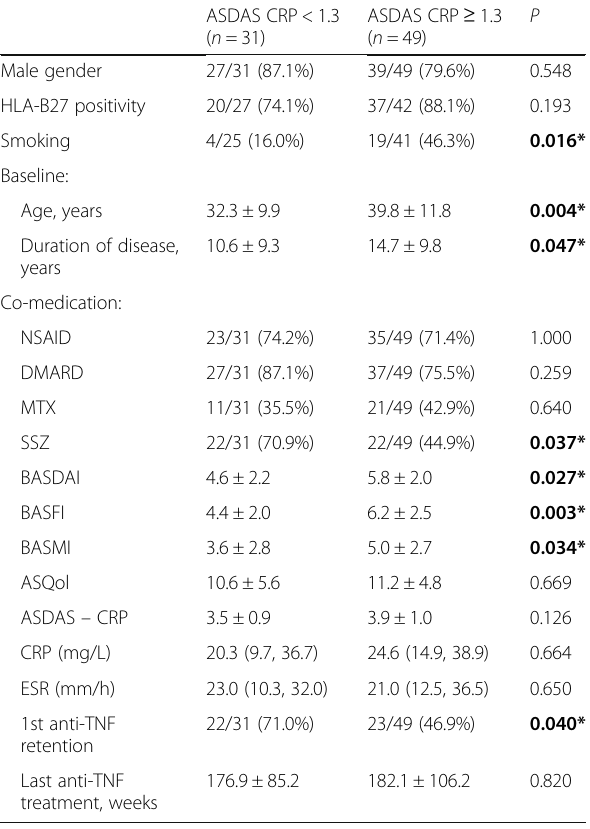
Table 3 Baseline comparison between patients according to inactive disease criteria (ASDAS – CRP < 1.3)